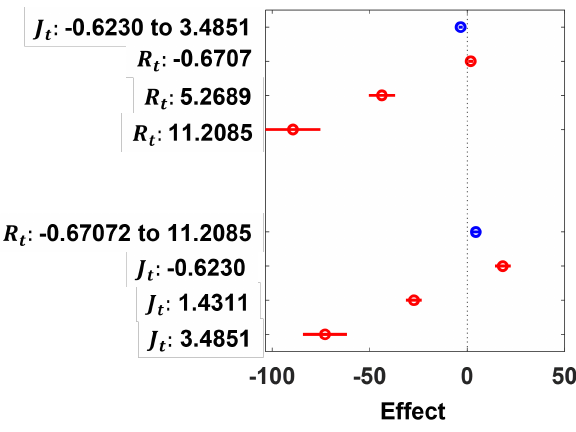
Figure 13. Interaction effect: J t and R t metrics for all the SDN